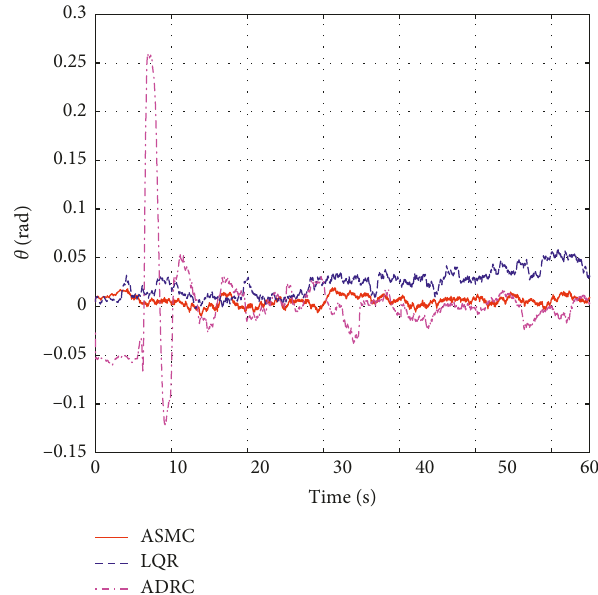
Figure 14: Tracking results of pitch angle under the wind speed of 2.8 m/s.